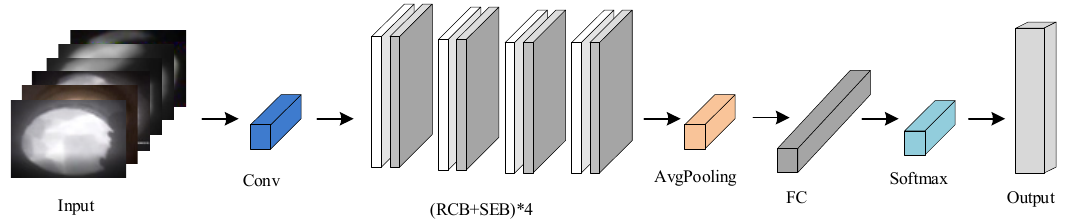
Figure 2. Residual convolutional neural network architecture based on channel attention.